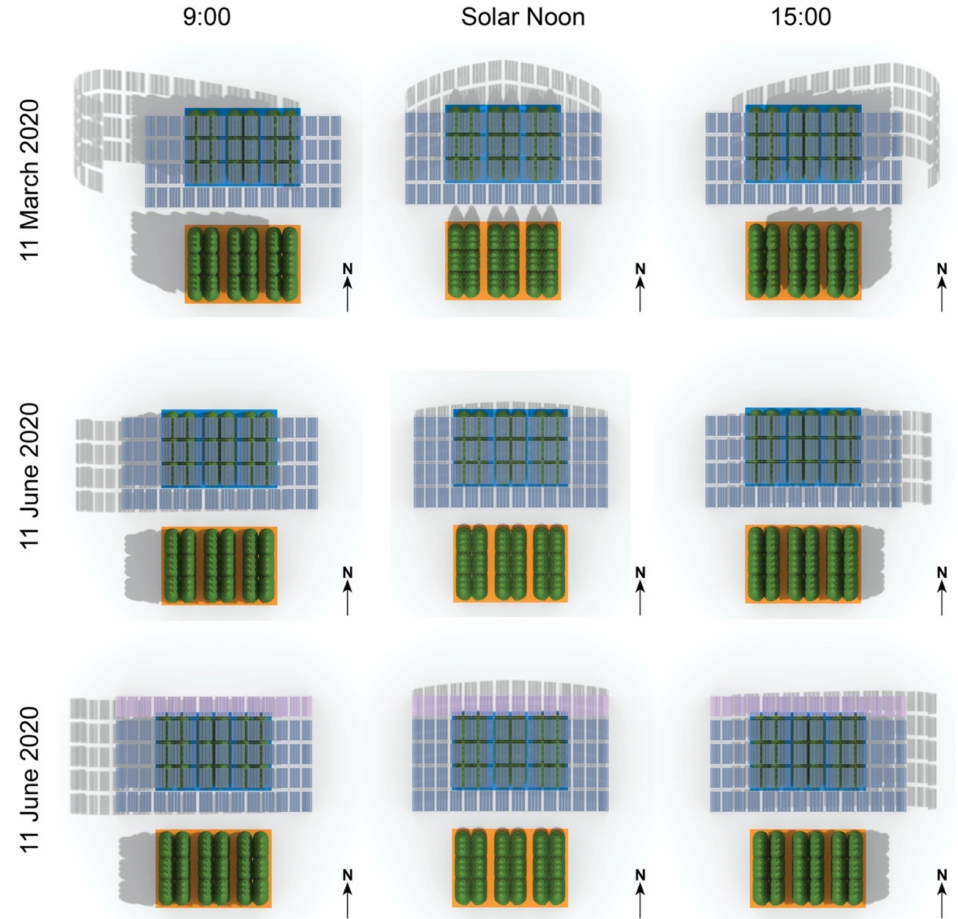
Figure 2. Simulated shadows cast by OPV shade element installed on greenhouse roof on the OPV planting area floor (highlighted in blue), showing the highest amount of southern exposure at the beginning of the measurement period (11 March 2020) and the highest amount of northern exposure (11 June 2020), when two additional OPV arrays were installed to increase